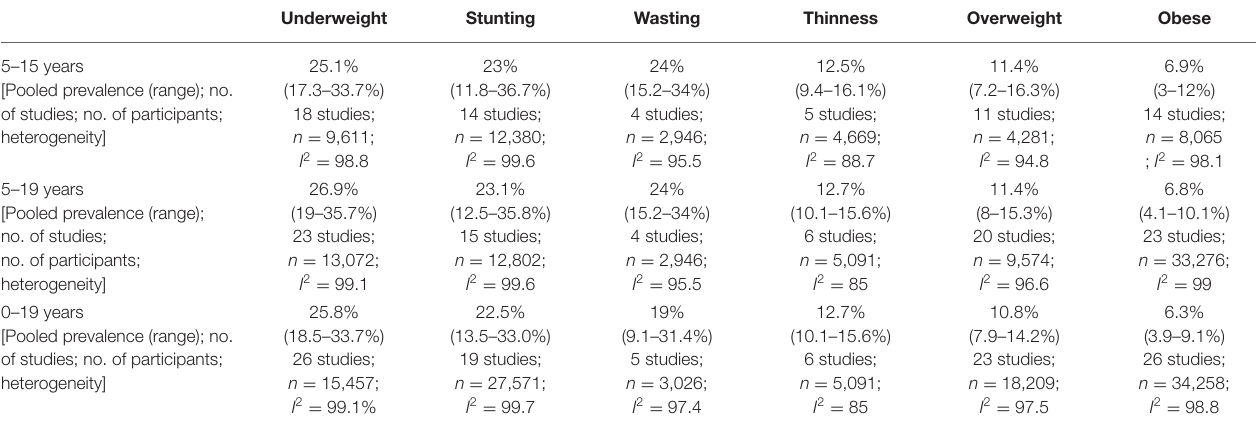
TABLE 3 | Prevalence of Anthropometric Measures in Pakistan according to age groups. Underweight Stunting Wasting Thinness Overweight